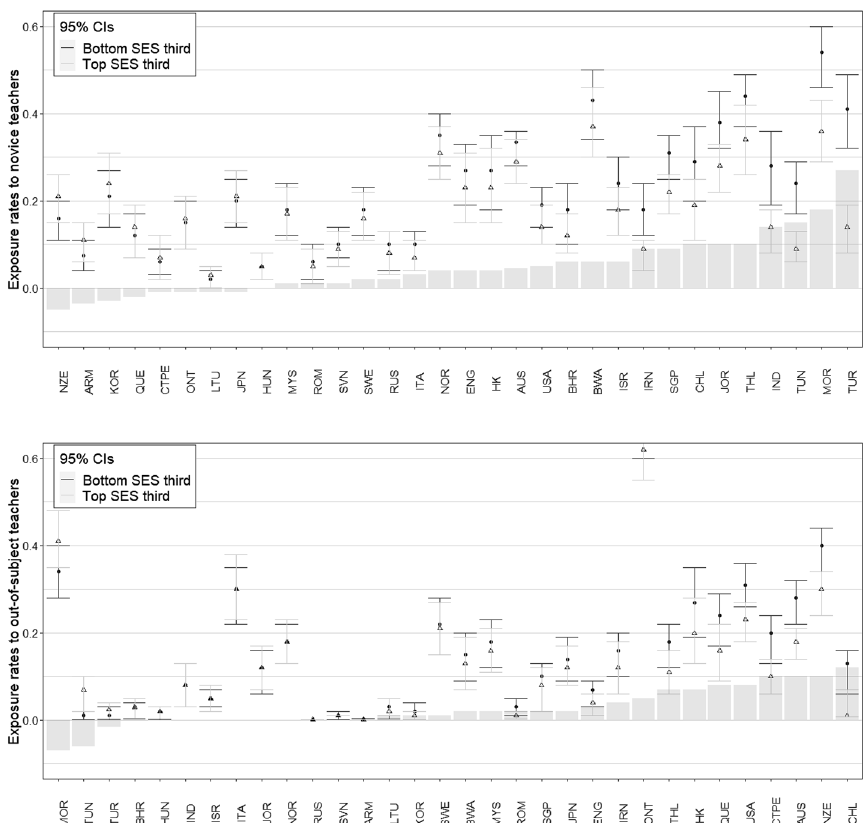
Fig. 1 Student exposure rates to novice and out-of-subject teachers from the most recent TIMSS cycle (2011–2019). Education systems’ most recent cycle is 2019 with the exception of Armenia (2015), Botswana (2015), Indonesia (2011), Slovenia (2015), Thailand (2015), and Tunisia (2011). Grey columns show teacher qualification gap magnitudes (the difference between low- and high-SES student exposure